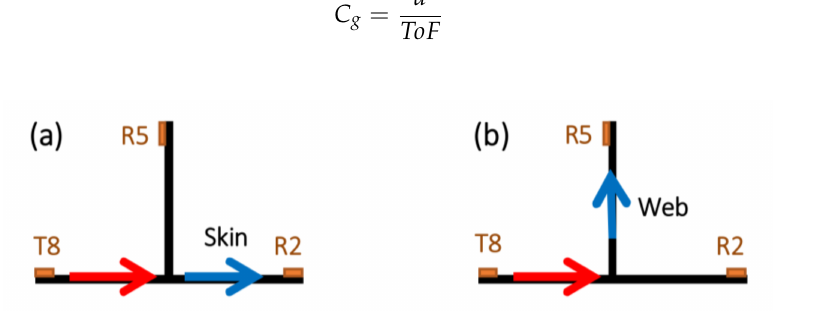
Figure 3. Schematic representation of paths: ( a ) on skin, from ‘T8’ to ‘R2’; and ( b ) on web, from ‘T8’ to